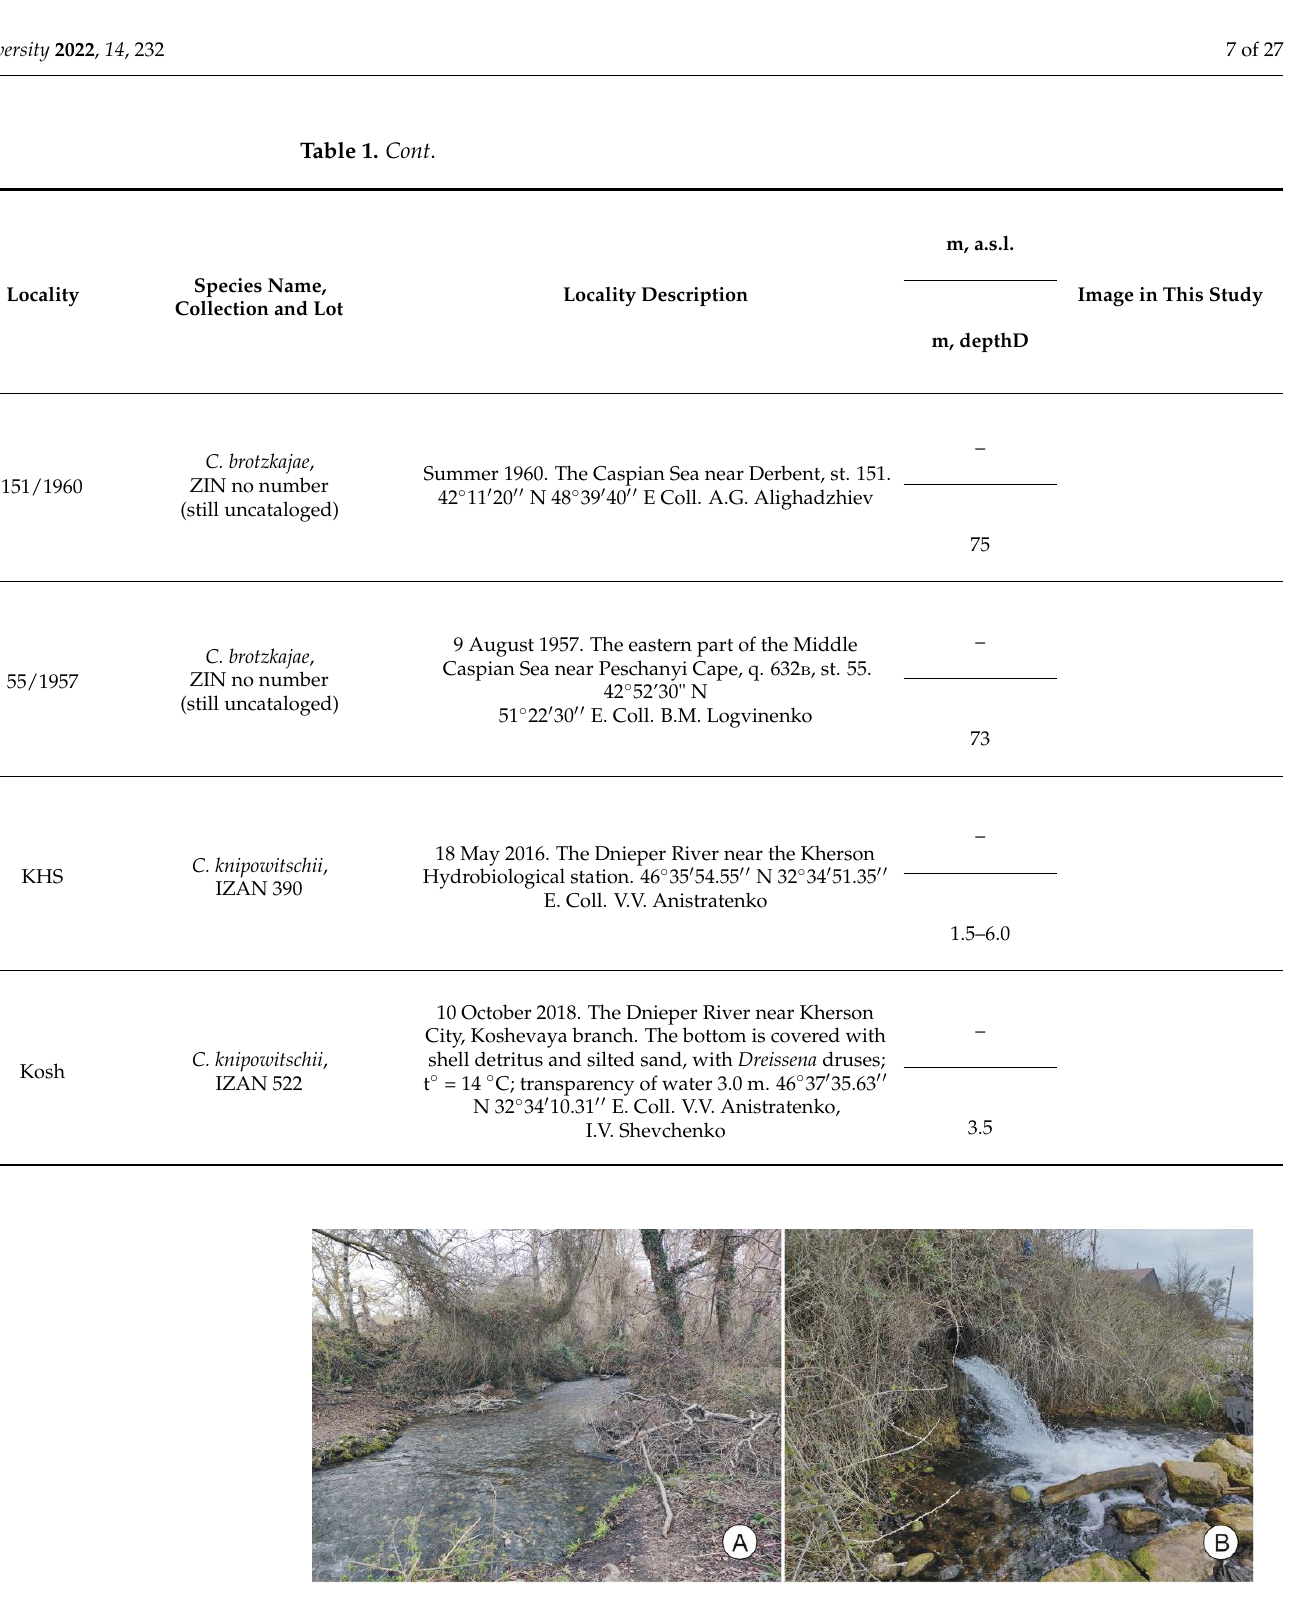
Figure 2. Images illustrating the diversity of biotopes inhabited by Clathrocaspia in the Samur Forest area. ( A ) — One of the channels of the Karasu River (locality Dag01); ( B ) — A fish pond drain at the northern end of Primorskiy village (locality Dag13); ( A – C ) spring by a river on the Caspian Sea coast (locality Dag23); ( D ) — The Yalama River, 30 m above the mouth, on an open beach of the Caspian Sea (locality Dag15); ( E ) — The Yalama River in a lowland forest near Bilbil-Kazmalyar village (lo- cality Dag24); ( F ) — A forest stream, north of Bilbil-Kazmalyar village (locality Dag30); ( A – G ) small forest river (locality Dag21); ( H ) — A forest stream among the bushes on the eastern outskirts of Ta- girkent-Kazmalyar village (locality Dag32).